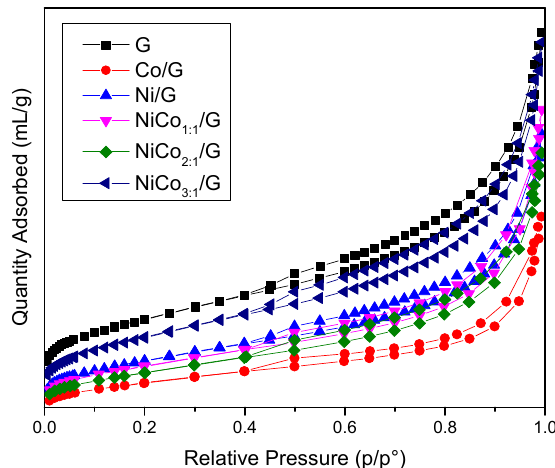
Figure 1. N 2 -sorption isotherm obtained for the support and the prepared catalysts.